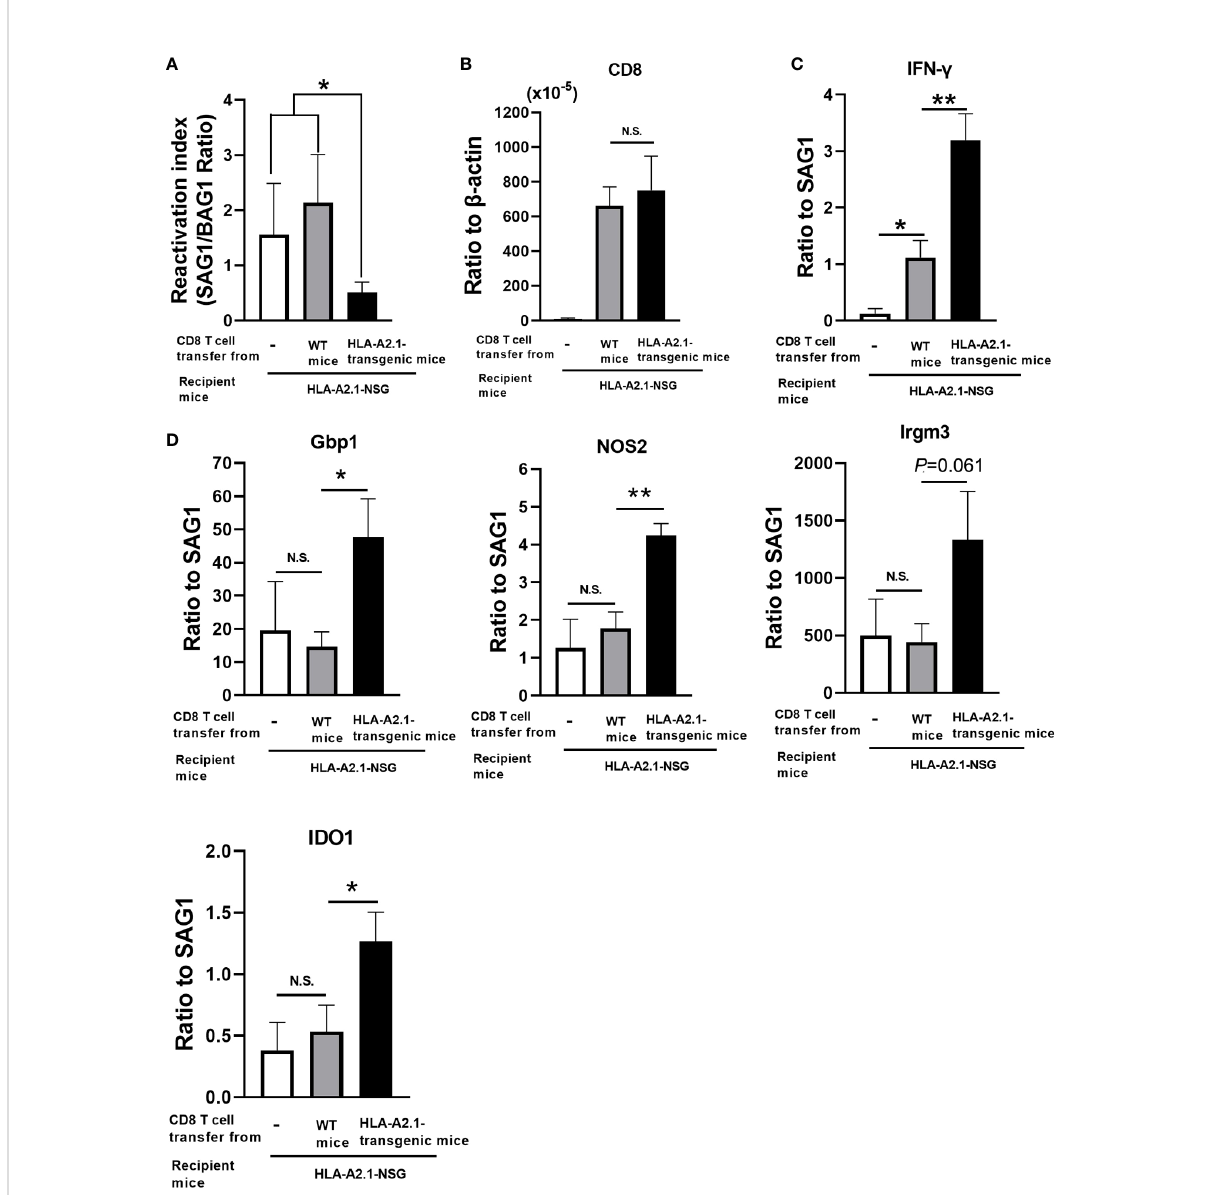
FIGURE 6 Adoptive transfer of CD8 + T cells from T. gondii -infected HLA-A2.1-transgenic mice confers a greater protection against reactivation of cerebral infection with the parasite in infected, immunode fi cient NSG mice expressing the HLA-A2.1 than do a transfer of the T cells from infected WT control mice. CD8 + T cells were puri fi ed from the spleens of infected HLA-A2.1-transgenic and WT mice at 4 weeks after discontinuation of sulfadiazine. These CD8 + T cells (2 x 10 6 cells) were injected intravenously from a tail vein into infected, sulfadiazine-treated immunode fi cient NSG mice expressing the HLA-A2.1 at 4 weeks after infection. An additional group of the HLA-A2.1-expressing NSG mice did not receive any T cells as a control. Five days after the T cell transfer, sulfadiazine treatment on the recipients was discontinued to initiate reactivation of the infection. Four days after the initiation of reactivation of the infection, (A) the reactivation index (ratios of the SAG1 mRNA levels to the BAG1 mRNA level), (B) the ratios of mRNA levels for CD8 b to mRNA levels for b -acting, and the ratios of mRNA levels for (C) IFN- g and (D) IFN- g - mediated effector molecules (Gbp1, NOS2, Irgm3, and IDO1) to mRNA levels for tachyzoite-speci fi c SAG1 were measured by real-time RT-PCR on the brains. * P <0.05, ** P <0.01. N.S. Not signi fi